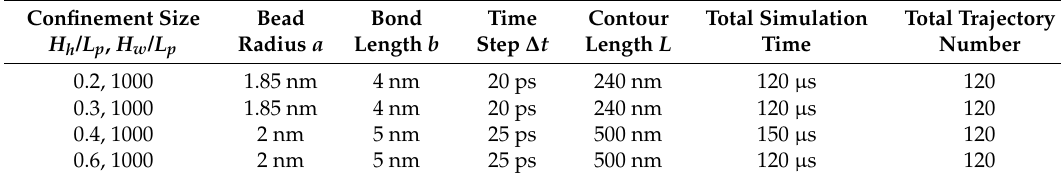
Table 6. Simulation parameters for the confinement of slits (cross).